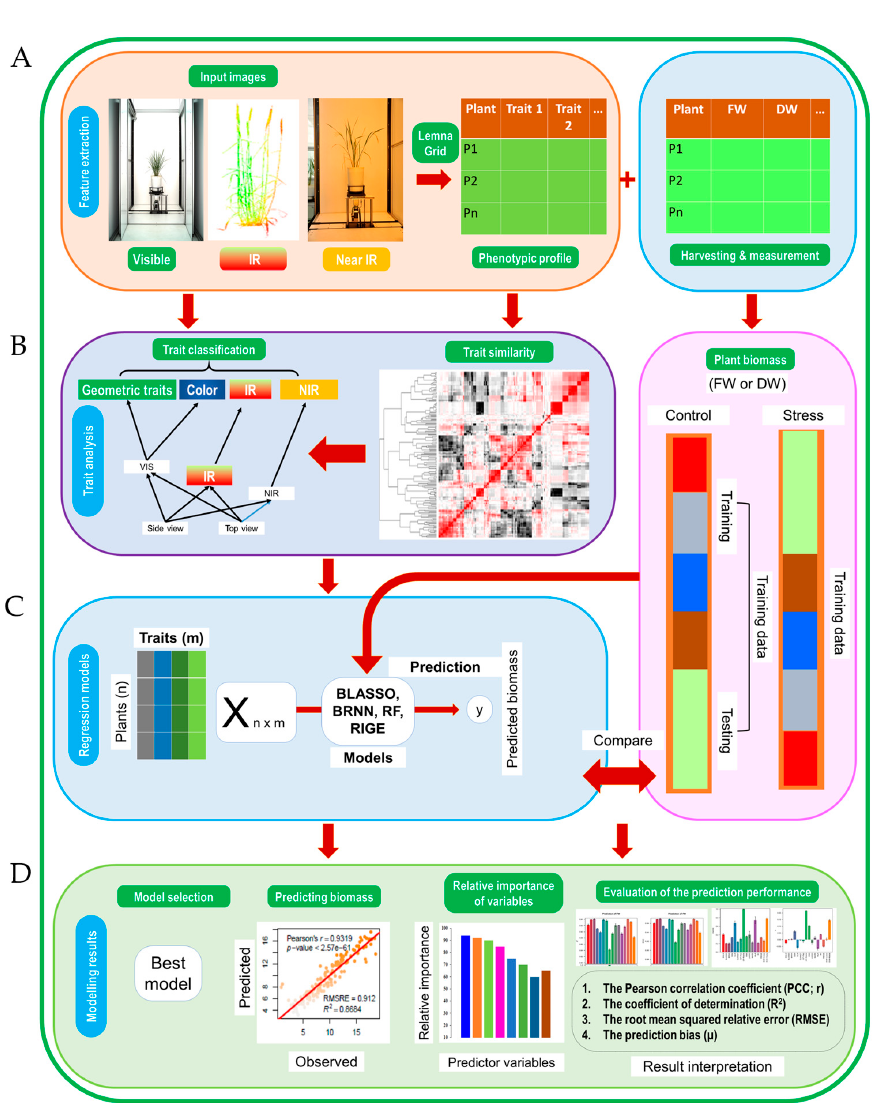
Figure 2. Workflow for predicting biomass of rice plants through image-derived feature traits and ML models. ( A ) Manual and image data collection: VIS, IR and NIR images were acquired using standard image unit configuration (IUC) set up, and LemnaGrid software (LemnaTec, Scanalyzer3D system) was used for image processing and feature extraction. After imaging, plants were harvested to measure fresh (FW) and dry weight (DW) weight. ( B ) The image-derived trait features were classified into four groups, viz ., geometric-, color-, IR- and NIR-related traits; Principal component analysis was used, and trait similarity map was constructed, to identify the novel i-traits for image-based biomass prediction. ( C ) The selected i-traits (projected shoot area, Area-SV-0, Area-SV-90, Area-SV-120 and Area-TV) were used as independent variables to predict response variable, i.e., plant biomass (FW and DW). A total of 16ML models were constructed using the group wise (control, N stress and control+ N stress) training and testing data sets (90: 10%, respectively) along with 10-fold cross- validation as a quality control feature. ( D ) Best performing machine learning model was identified using performance indicators such as Pearson correlation coefficient (r) at a p < 0.001 significance level, coefficient of determination (R 2 ), root mean squared error (RMSE) and prediction bias ( µ